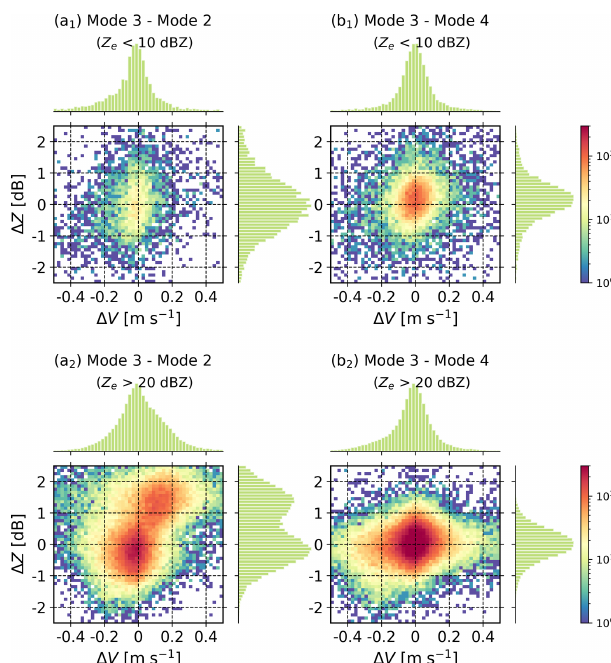
Figure 10. Same as Fig. 9 but for the Ka-band radar. Note that the data at mode 1 were excluded due to the limited Nyquist